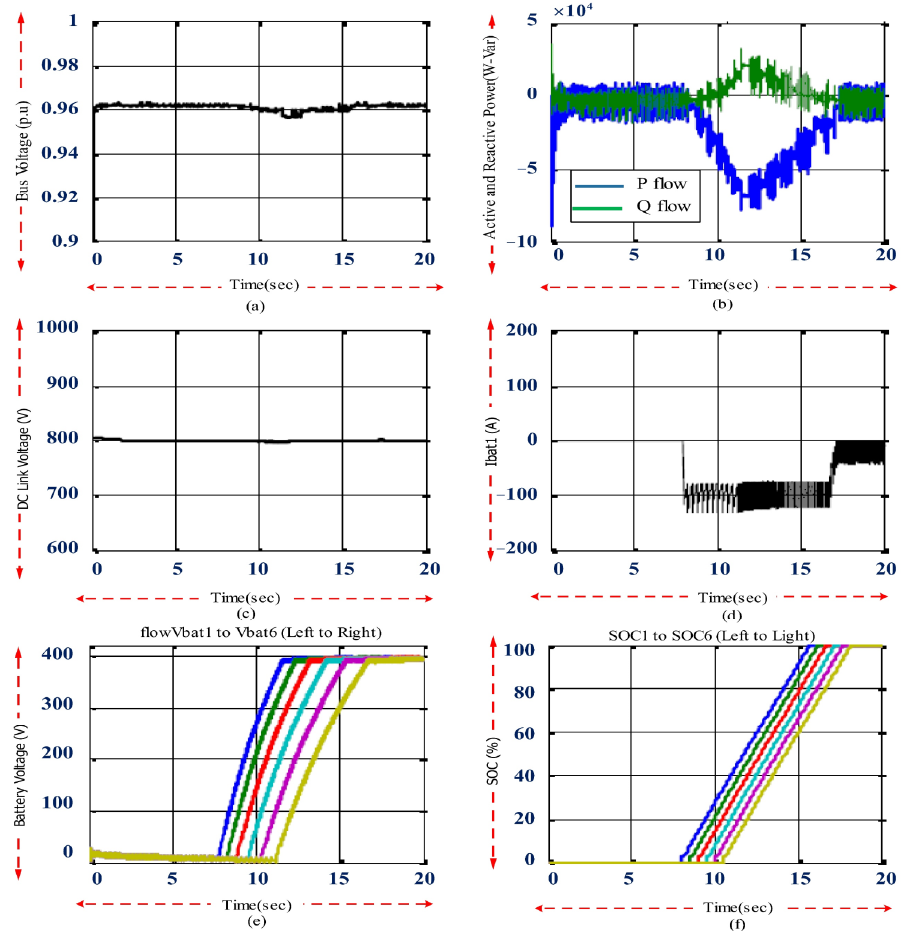
Figure 15. The results of fast charging of EVs with reactive power compensation control at bus voltage of 0.96 p.u. ( a ) Bass voltage; ( b ) exchange of active and reactive power; ( c ) link voltage; ( d ) battery current; ( e ) battery voltage; ( f ) SOC.